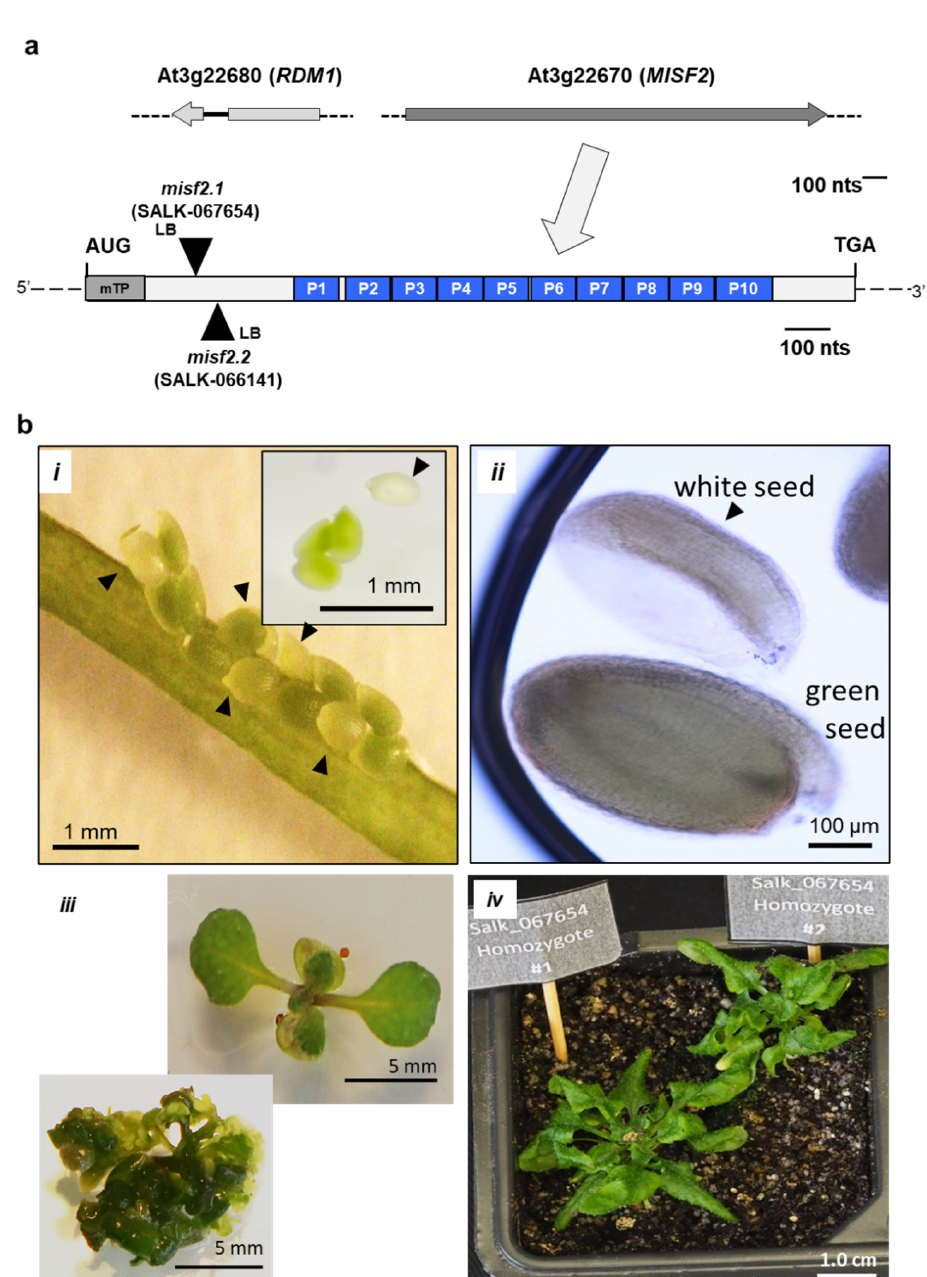
Figure 1. MISF2 (At3g22670) gene topology and misf2 mutant phenotypes. ( a ) Scheme of the At3g22670 locus and gene structure. The large arrow points toward motif-structure arrangements of the MISF2 coding region. The position of the two T-DNA insertion sites in the coding region of MISF2 (i.e., SALK-line 067654, misf2.1 , SALK-line 066141, and misf2.2 ) are located 324 and 350 nucleotides downstream to the ATG start codon, in a region that corresponds to the N-terminal domain of MISF2, upstream of the PPR motifs. ( b ) Morphologies of misf2 hetero- and homozygous mutants. Green and white seeds harboring wild-type/heterozygous and homozygous mutant embryos respectively were collected from surface-sterilized immature siliques of heterozygous misf2 plants ( i ) and sown on MS agar media supplemented with vitamins. Arrows point toward white seeds. Panel B ( ii ) shows differential interference contrast microscopy images (i.e., Nomarski) of embryos found in green or white seeds. Following germination, a few rescued homozygous misf2 plantlets ( iii ) were able to survive on soil, although failed to set flowers and viable seeds ( iv